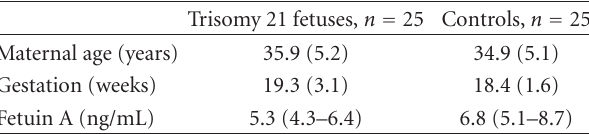
Table 1: Descriptive characteristics of women (mean (standard de- viation)) and levels (median (25th–75th percentile)) of fetuin A ac- cording to fetal status (trisomy 21 or euploid).